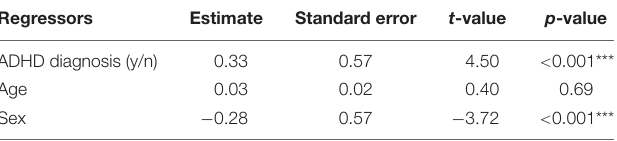
TABLE 4 | Regression of reactive aggression.